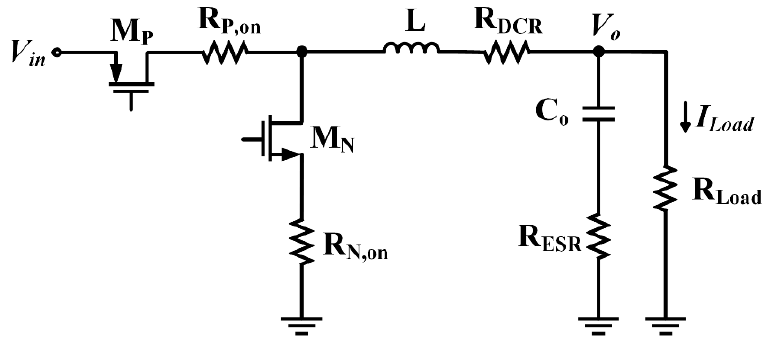
Figure 3. Power stage of buck converter including parasitic resistance.